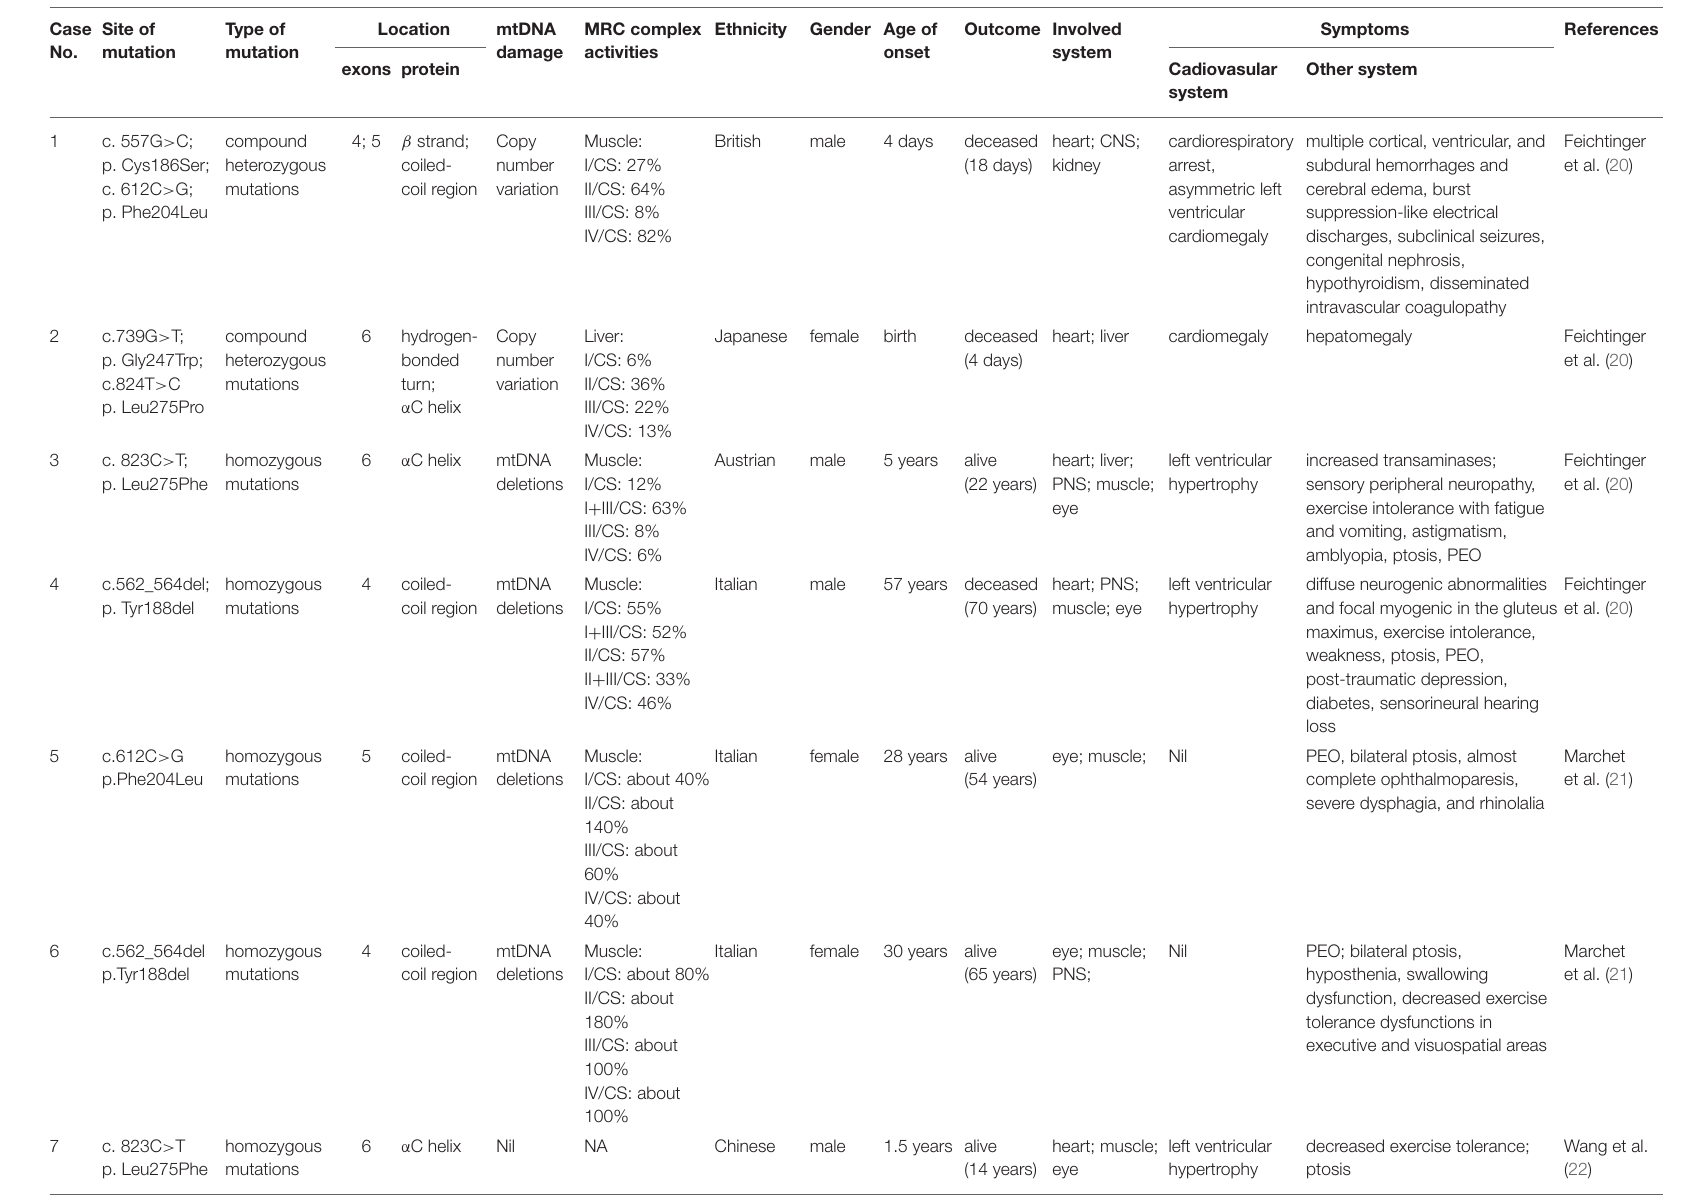
TABLE 1 | Disease-associated mutations of C1QBP in mitochondrial